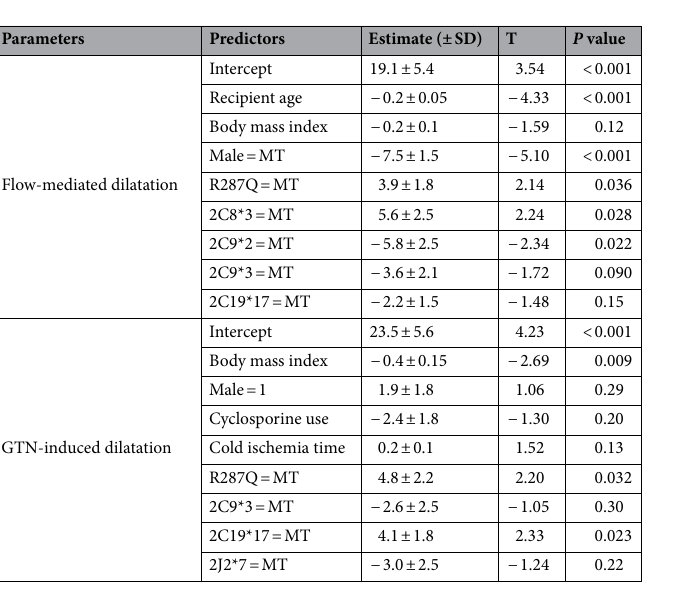
Table 3. Multiple linear regression of radial artery vascular function according to the predictors obtained from leaps analysis.